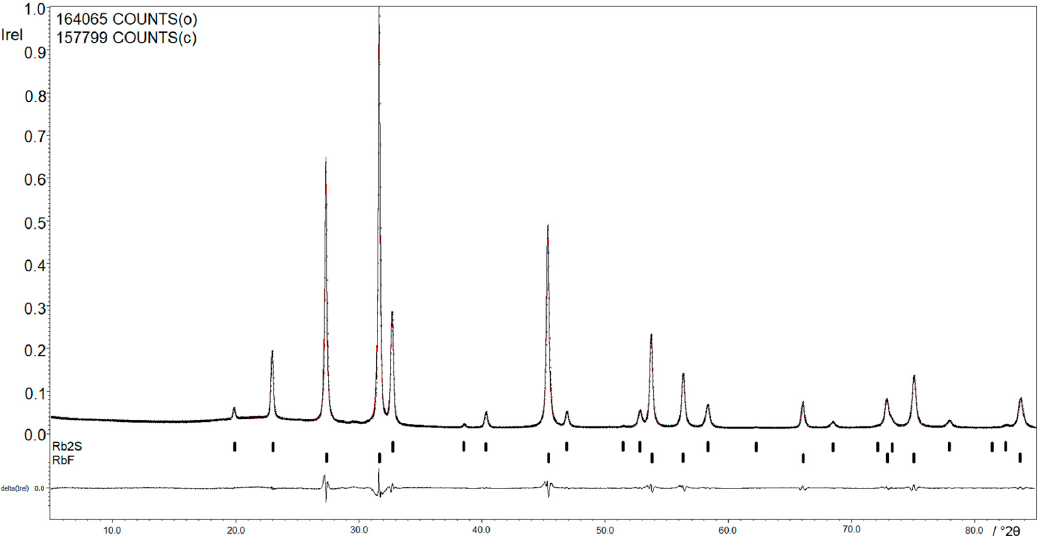
Figure 2. Rietfeld refinement of the X-ray powder diffraction pattern of RbF and Rb 2 S. The calculated reflection positions are represented by strokes below the observed and calculated powder pattern.